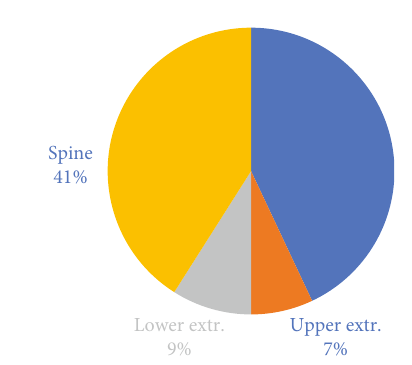
Upper extr. 7%Lower extr.